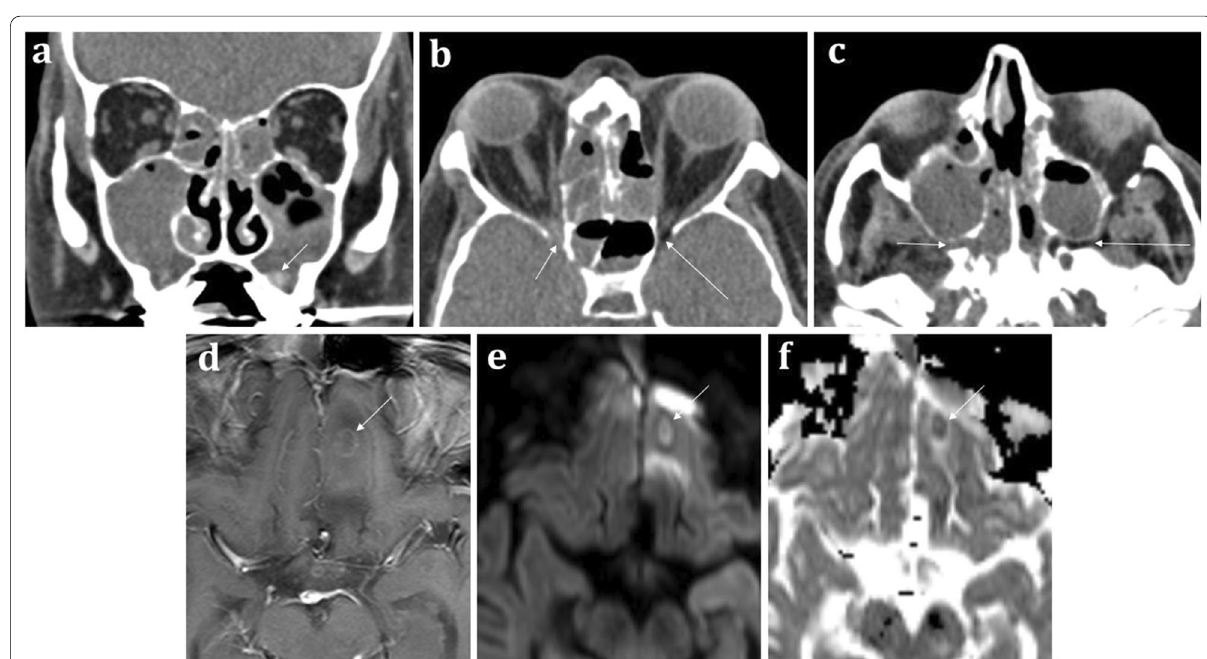
Fig. 8 60-year-old male with neutropenic sepsis on a background of allograft bone marrow transplant for acute myeloid leukaemia. Coronal soft tissue CT a demonstrates “bubbly” aerated secretions within the maxillary sinuses and ethmoid air cells bilaterally suggestive of acute sinusitis. Hyperdense regions are indicative of inspissated secretions or fungal elements (arrowed). Axial soft tissue CT images b , c illustrate subtle abnormal soft tissue at the right orbital apex (short arrow, b ) and the right pterygopalatine fossa (short arrow, c ), which suggests trans-spatial spread of disease. Appearances are consistent with acute invasive fungal sinusitis. On the contralateral side, the normal fat within these spaces is preserved (long arrows in b and c ). Axial T1W post-contrast ( d ), DWI ( e ), and ADC map ( f ) MRI sequences demonstrate a left inferior frontal lobe ring enhancing lesion with central diffusion restriction consistent with an intracranial abscess (arrowed)